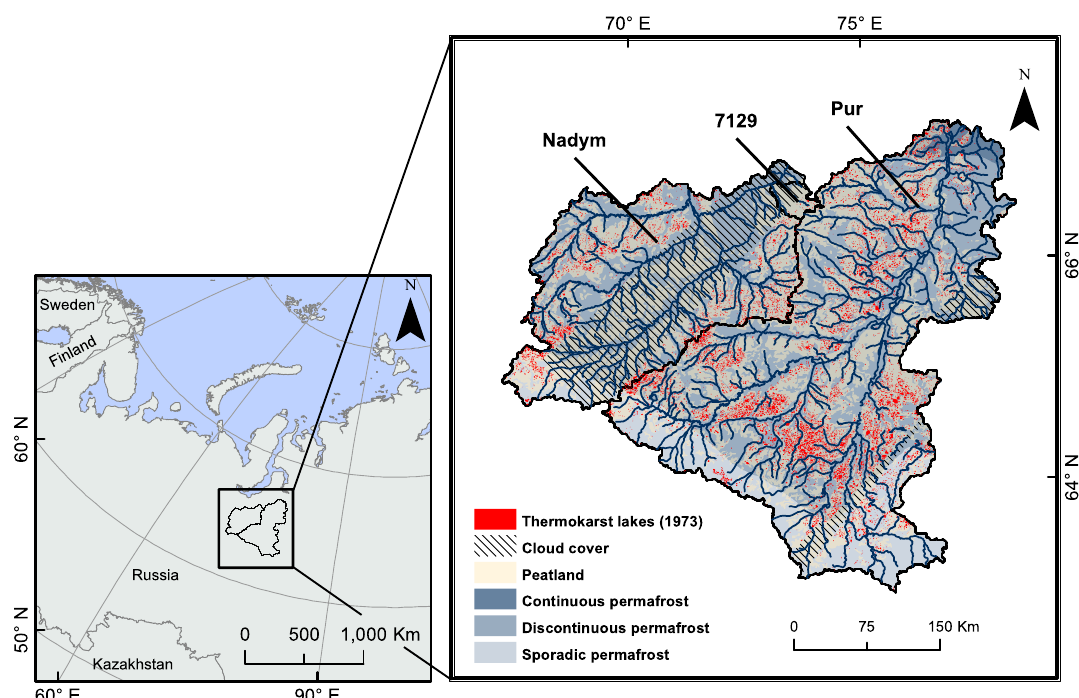
Figure 1. Location of Nadym and Pur river basins, and 7129 sub-basin, thermokarst lake distribution (as of 1973), permafrost distribution, peatland distribution, and areas excluded from the remote sensing study due to cloud